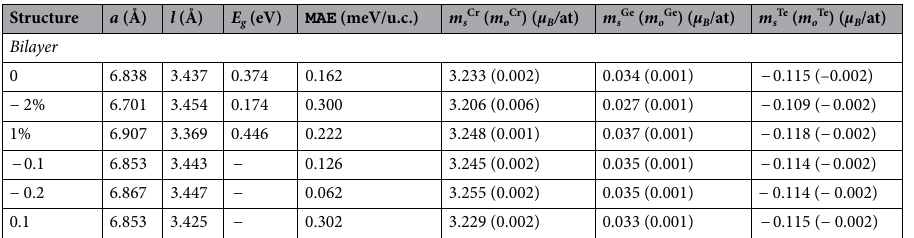
Table 1. The lattice constant a and interlayer distance l (vdW gap) of pristine (0) bilayer Cr 2 Ge 2 Te 6 used in the present calculations. E g and MAE stand for the band gap and magnetic anisotropy energy, respectively. Spin spin–orbit coupling included. The results under specific compressive strain (− 2%), tensile strain (1%), electron doping (− 0.1 e/u.c.) and hole doping (0.1 e/u.c.) are also included.